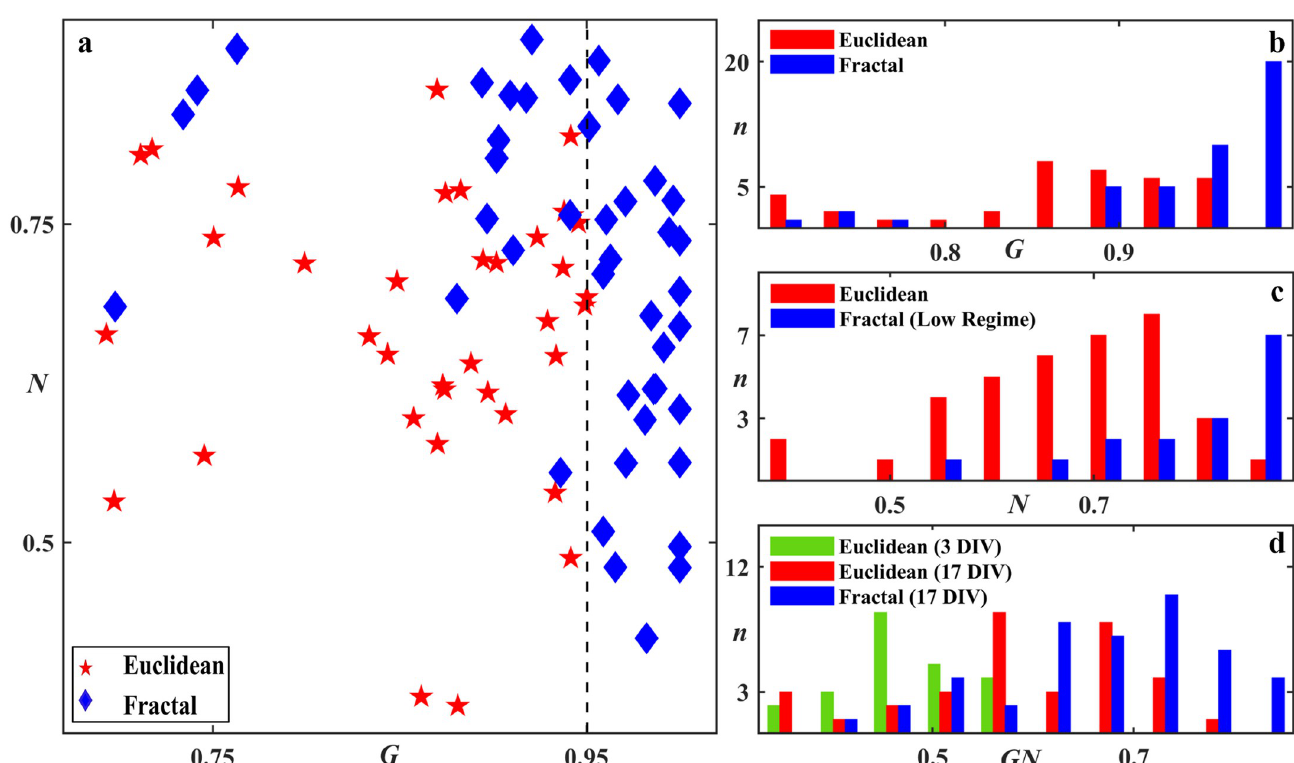
Fig 6. Quantification of herding. (a) Scatterplot of N (neuron herding) vs G (glial herding) at 17 DIV, for 38 Euclidean and 44 fractal electrodes where each data point represents one electrode (we display 0.5 < G � 1 for clarity but note that the one Euclidean electrode with G < 0.5 not shown here was included in the analysis). The dashed line marks the threshold value in G that no Euclidean electrode surpassed. (b) Histogram of the number of electrodes n with a given G for 17 DIV Euclidean and fractal electrodes. (c) Histogram of the number of electrodes n with a given N for 17 DIV Euclidean and low regime fractal electrodes. (d) Histogram of the number of electrodes n with a given GN for 3 and 17 DIV Euclidean plus 17 DIV fractal electrodes. Euclidean data for 7 DIV is not shown for clarity but follows the observed trend.